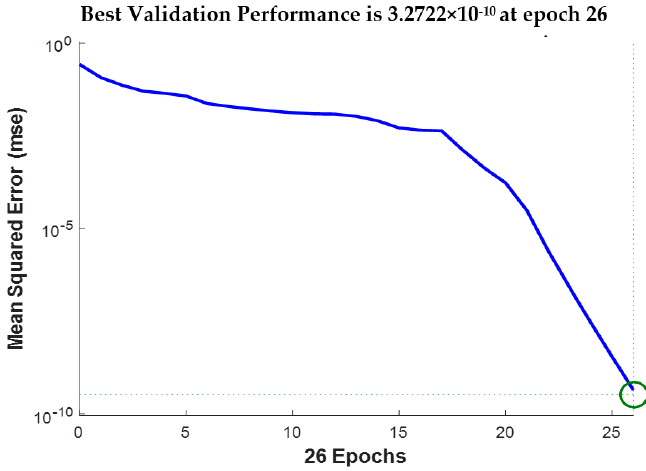
Figure 15. The training convergence curve of BP neural network.